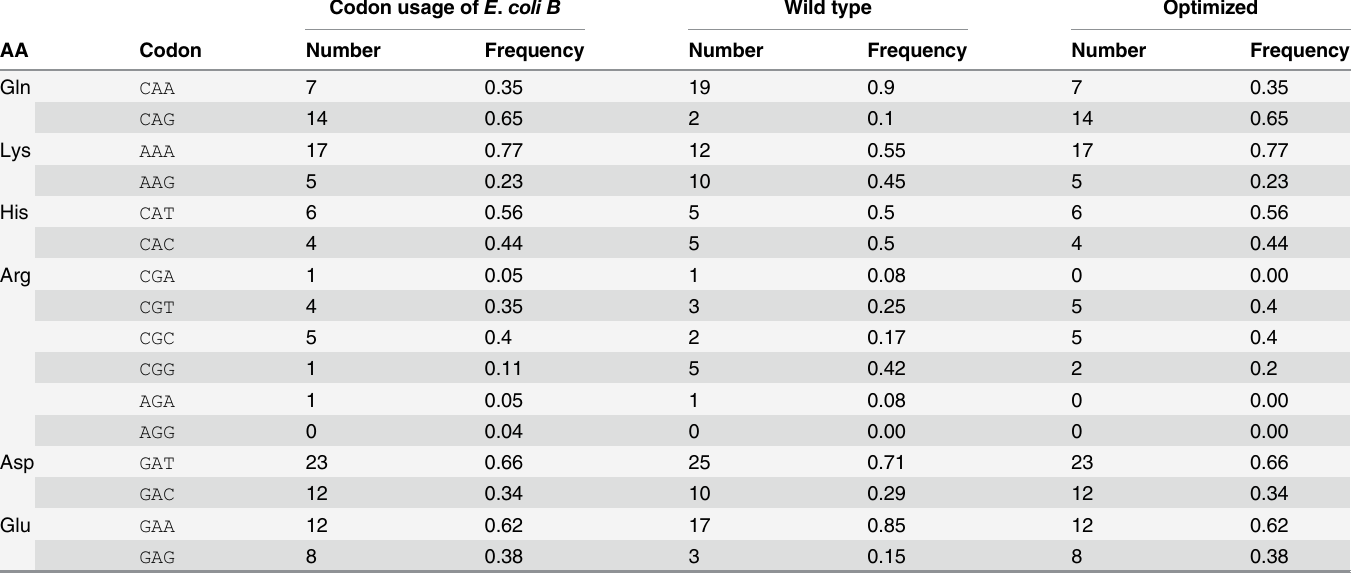
(underlined). The nox gene was obtained by the same method, with the forward and reverse primers (P3 and P4, Table 1) containing Xho I sites in the reverse primer (underlined). The PCR products were purified, generating the template of the overlapping PCR (SOE-PCR). The fusion gene, gdh - nox , was obtained by SOE-PCR using P1 and P4 primers with the following steps: 1 cycle at 95°C for 1 min; 30 cycles at 98°C for 10 s, 60°C for 15 s and 72°C for 3 min; and 1 final additional cycle at 72°C for 10 min. The purified PCR products were addressed with Bam HI and Xho I before reassembled into expression vector pET-32a (+), generating pET-32a- gdh - nox . The recombinant plasmids were sequenced and the positive recombinant plasmids were transformed into BL21 (DE3) for protein expression. Enzyme assay and biochemical characterization of the GDH-NOX. The enzyme mea- surement system of the NOX was consisted of 0.2 mM NADH, 100 μ L buffers with different pH and a moderate amount of crude enzyme. The activity of the GDH was determined by adding moderate crude enzyme under the following conditions: 30 mM (NH glycerol, 2 mM NAD + and 0.1 M buffer with different pH [30]. To determine optimal tempera- tures for the NOX and GDH activities, the fusion enzyme was assayed at the gradient tempera- tures of 25 – 55°C in the above reaction system. The fusion enzyme solution for the reaction was adjusted to pH 5.0 – 12.0 to detect optimal pH for the NOX and GDH. The V glycerol and NADH of the GDH-NOX were determined by measuring the enzyme activity with the glycerol substrate (concentration of 0.01, 0.125, 0.014, 0.025 and 0.05 M) and the NADH substrate (concentration of 20, 40, 60, 100 and 200 μ M) respectively, at the optimum